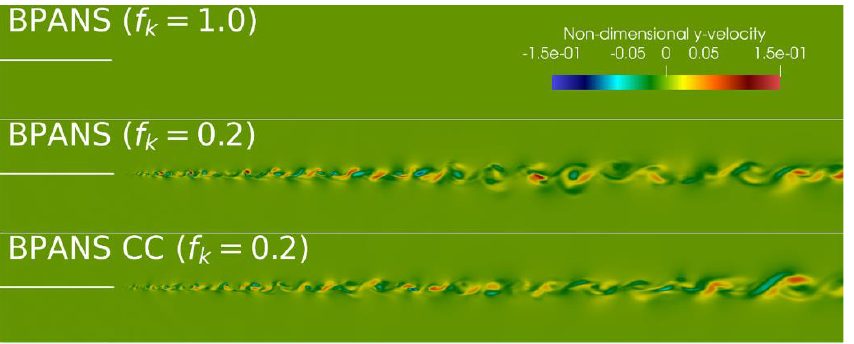
Figure 3. Mixing layer y-velocity contours at the y-centerline. The RANS results ( 𝑓 𝑘 = 1.0 ) do not exhibit unsteadiness and thus have a y-velocity of zero. The velocity is nondimensionalized by the upper plate velocity.